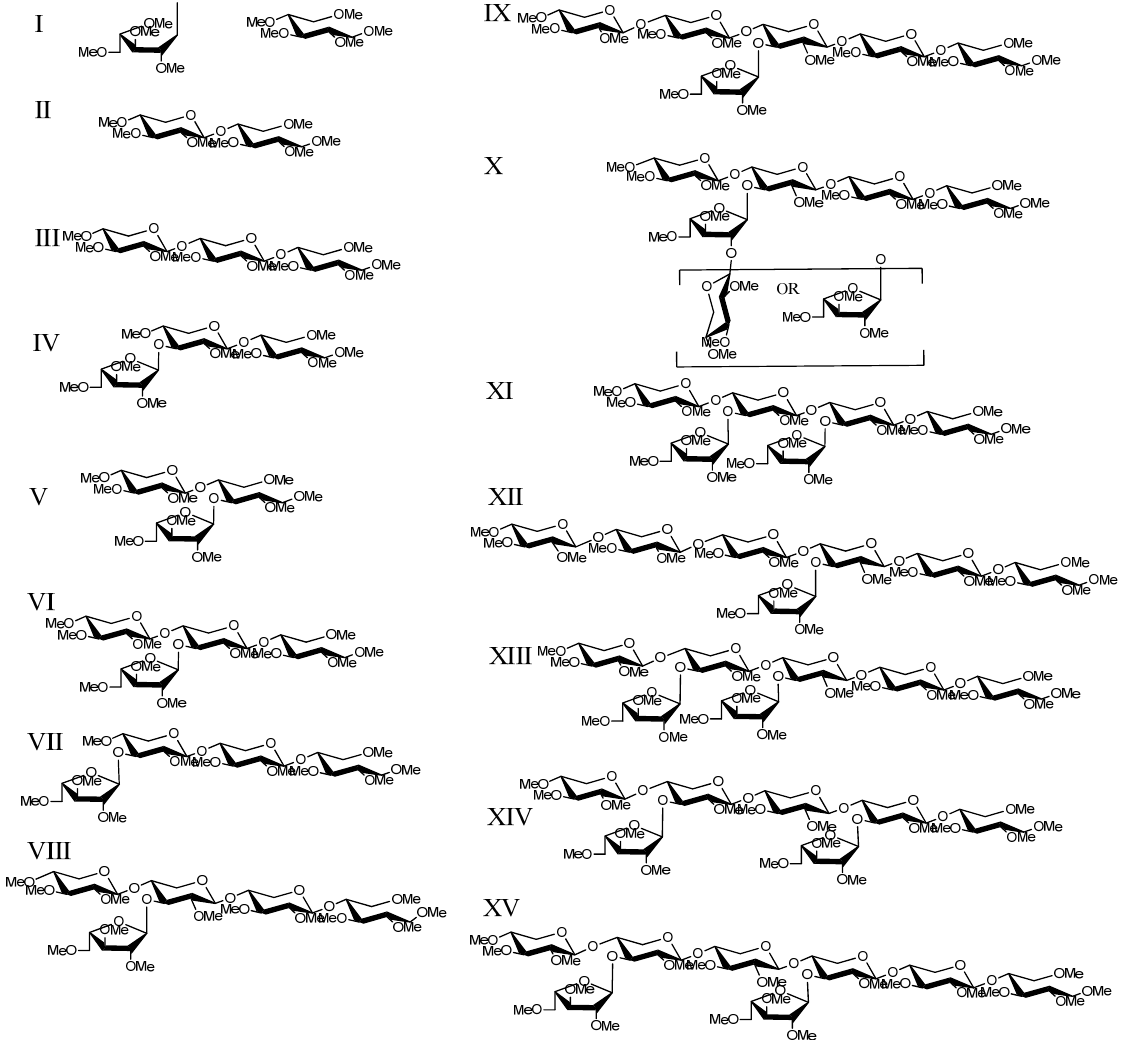
Figure 3. Structures present in T. viride endo-xylanase digested SG